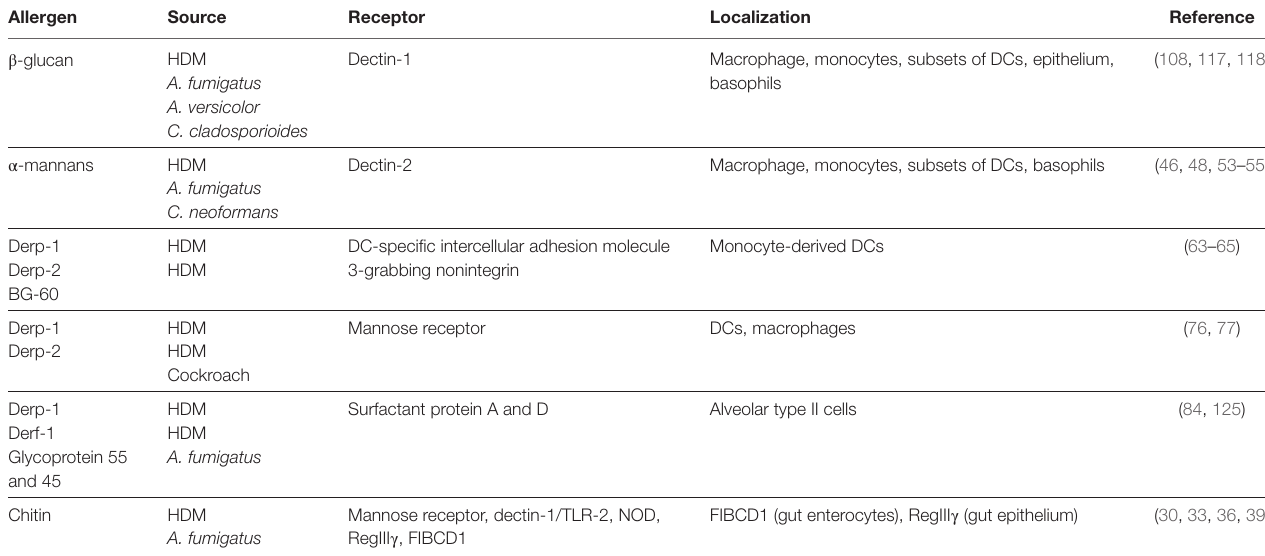
TAbLe 1 | Common allergens found in fungi and house dust mites (HDM) and their binding receptors.